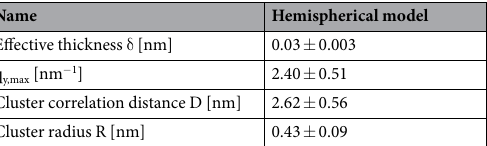
Table 2. Calculated structural values for soft-landed Au 9 sample assuming hemispherical model.